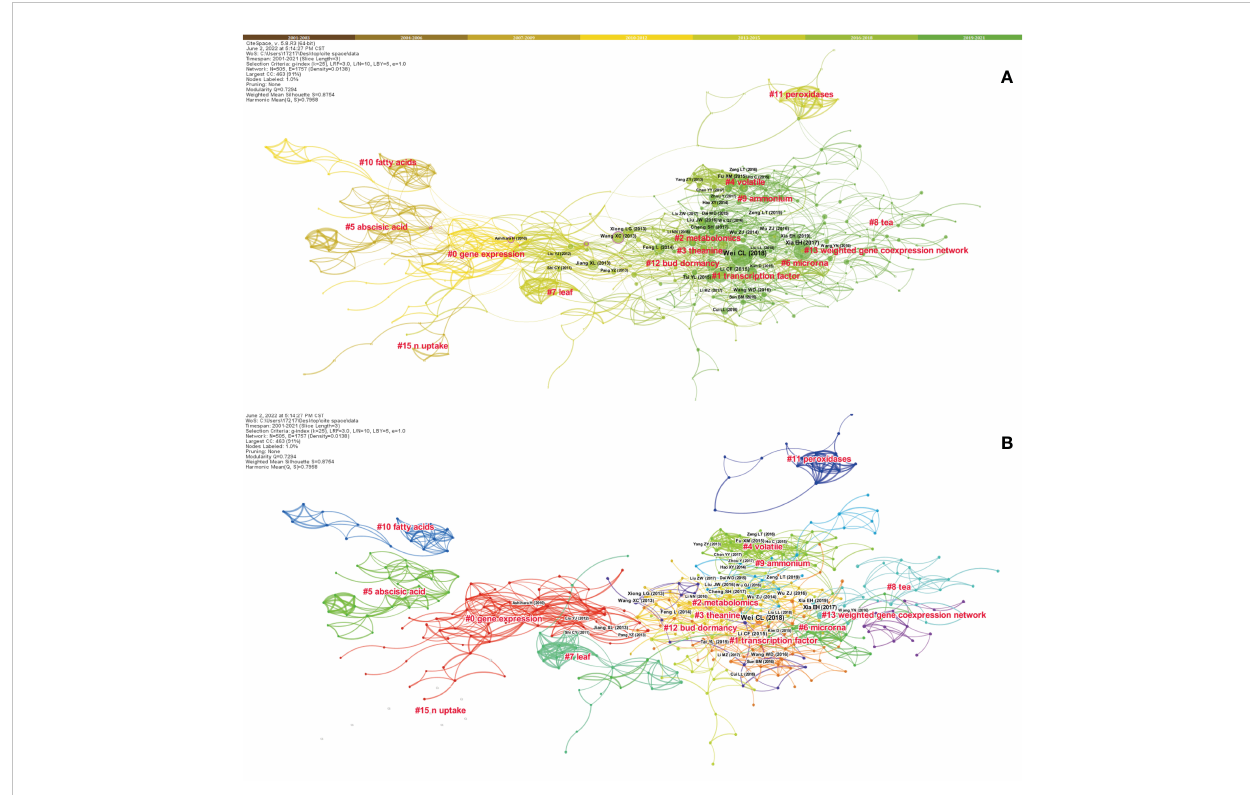
FIGURE 8 Co-citation references network (1980 – 2021) and correspondent clustering analysis obtained with CiteSpace. (A) Co-citation reference network with cluster visualization. The size of each node represents the citations of each reference. Colors closer to the middle of the node represent older publication years, whereas exterior colors are more recent publication years. The purple circle means the node ’ s centrality ≥ 0.1, and the size of the circle is proportional to the centrality value. (B) Visualization map of the corresponding